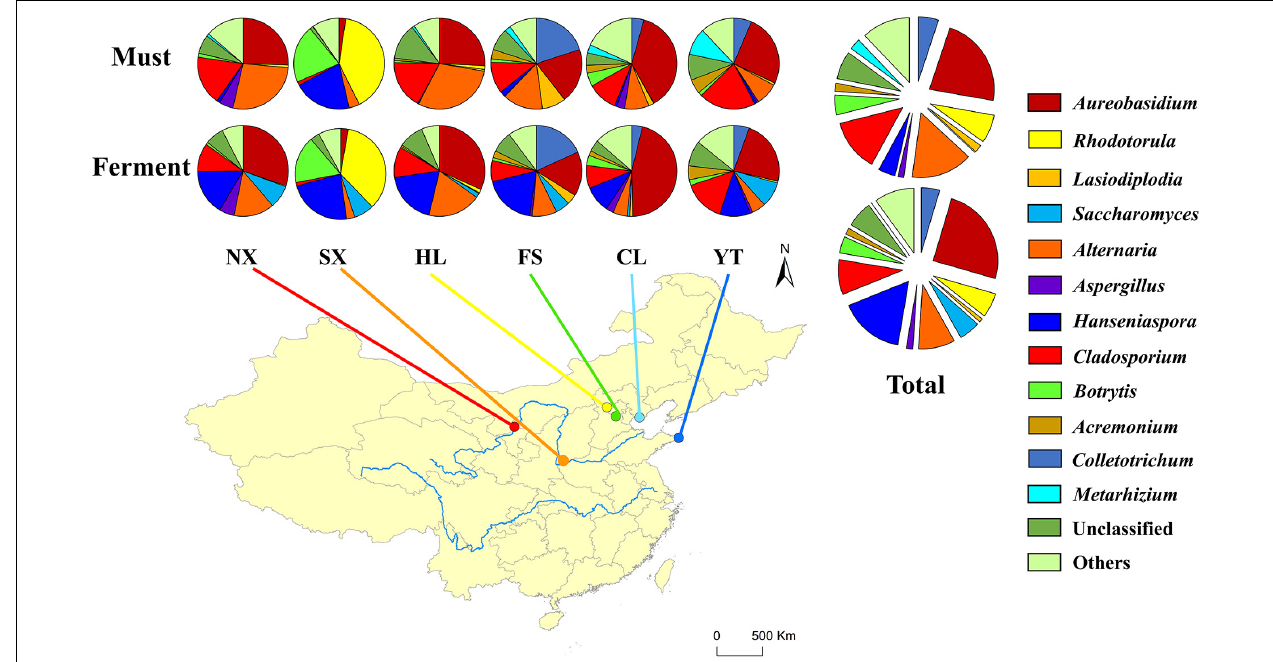
FIGURE 1 | Relative abundance percentages (%) of the Marselan must and fermented sample fungal genera from different regions.